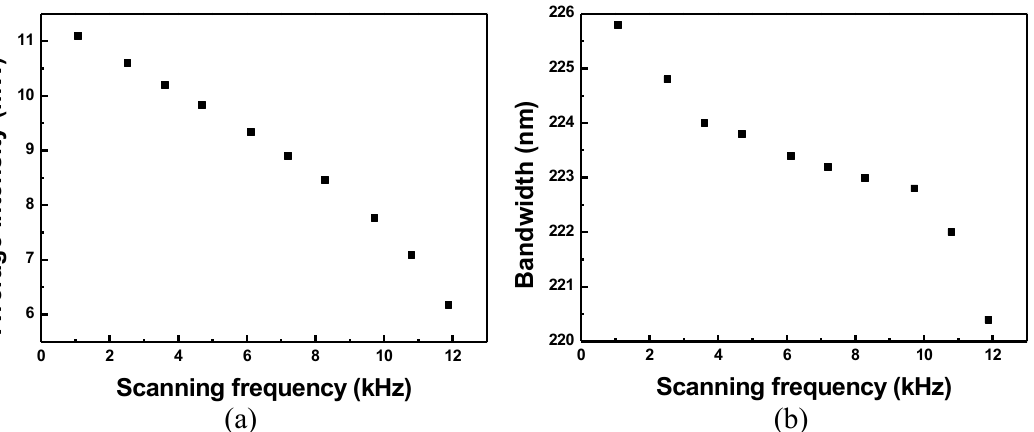
Figure 9. Output characteristics of wideband WSL according to the scanning frequency; ( a ) average intensity, and ( b ) scanning bandwidth.